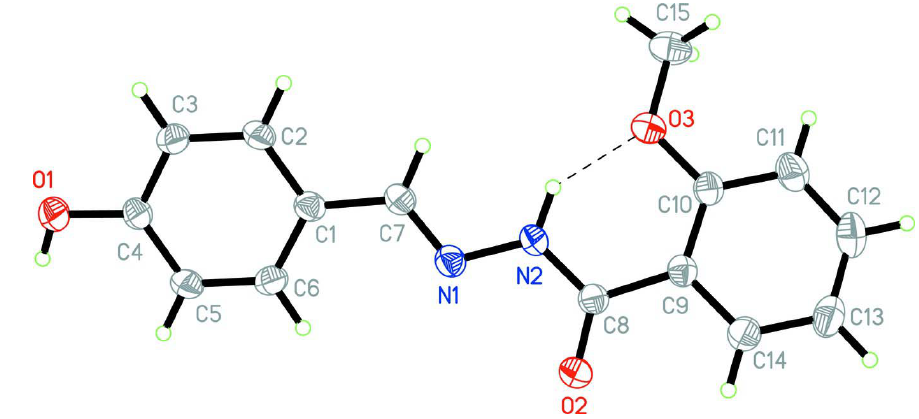
Figure 1 The molecular structure of compound (I), with 30% probability displacement ellipsoids for non-H atoms.